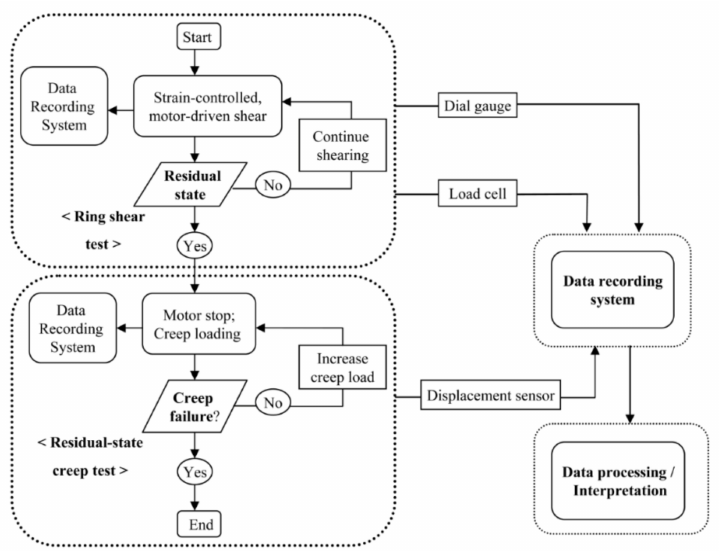
Figure 2. Overall experimental flow of the residual-state creep